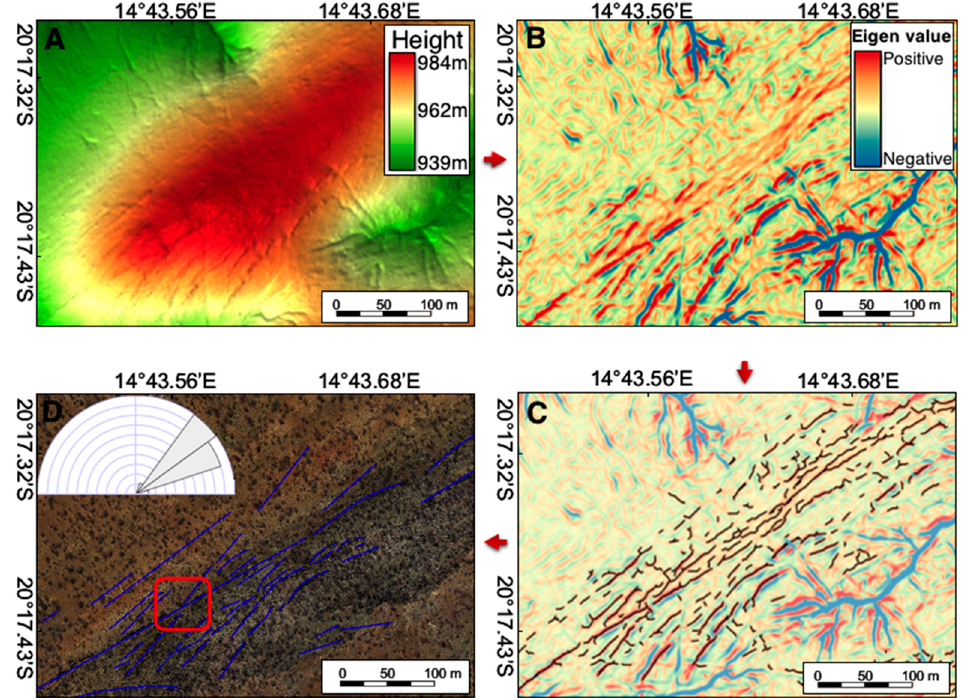
Figure 11. Flow diagram showing the process of topographical analysis. ( A ) High-resolution DEM derived from photogrammetry. ( B ) Maximum magnitude of eigenvectors (positive for ridges and negative for valleys). ( C ) Automatic extracted linear features (after applying a buffer around gullies). ( D ) Resulting interpretation of the dykes and directional Rose diagram; encircled area is the focus of the RPAS-based hyperspectral imaging. Table 3. Steps for DEM analyses of feature extraction.